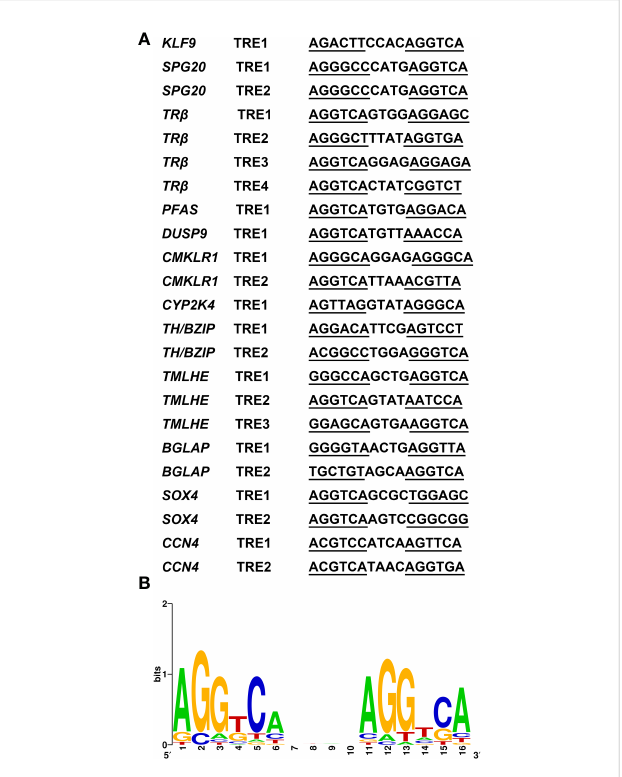
FIGURE 7 A consensus TRE predicted in Microhyla fi ssipes TR target genes. (A) Sequences of the 23 predicted TREs in M. fi ssipes . (B) Graphic representation of the consensus TRE generated from the 23 TREs above. The horizontal axis represents the positions of residues in the TRE, and vertical axis represents the relative frequencies of the four bases at each position as bits. TRE, thyroid response elements; TR, thyroid